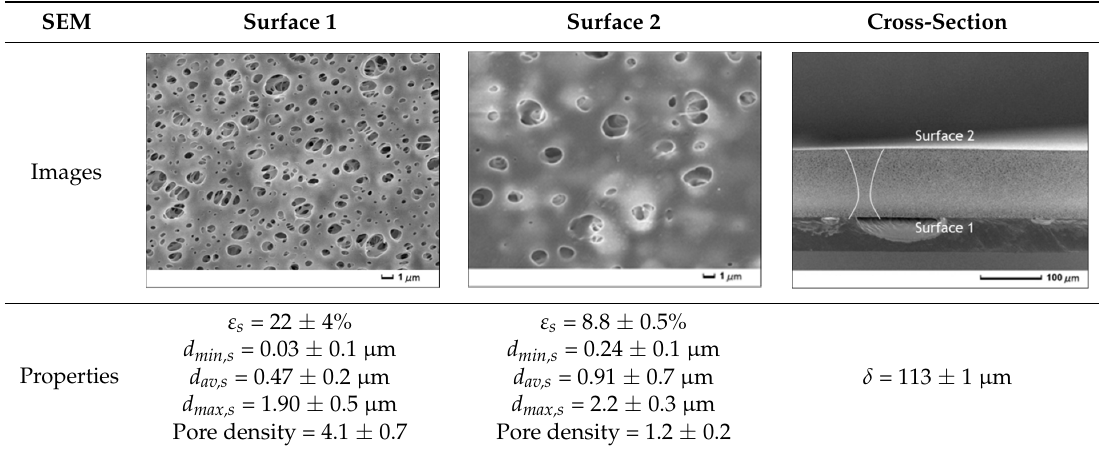
Table 2. Characteristics of the hydrophilic support membrane (polyethersulfone (PES)) and the membranes commonly used for membrane distillation (polyethylene (PE) and polyvinylidene fluoride (PVDF)).